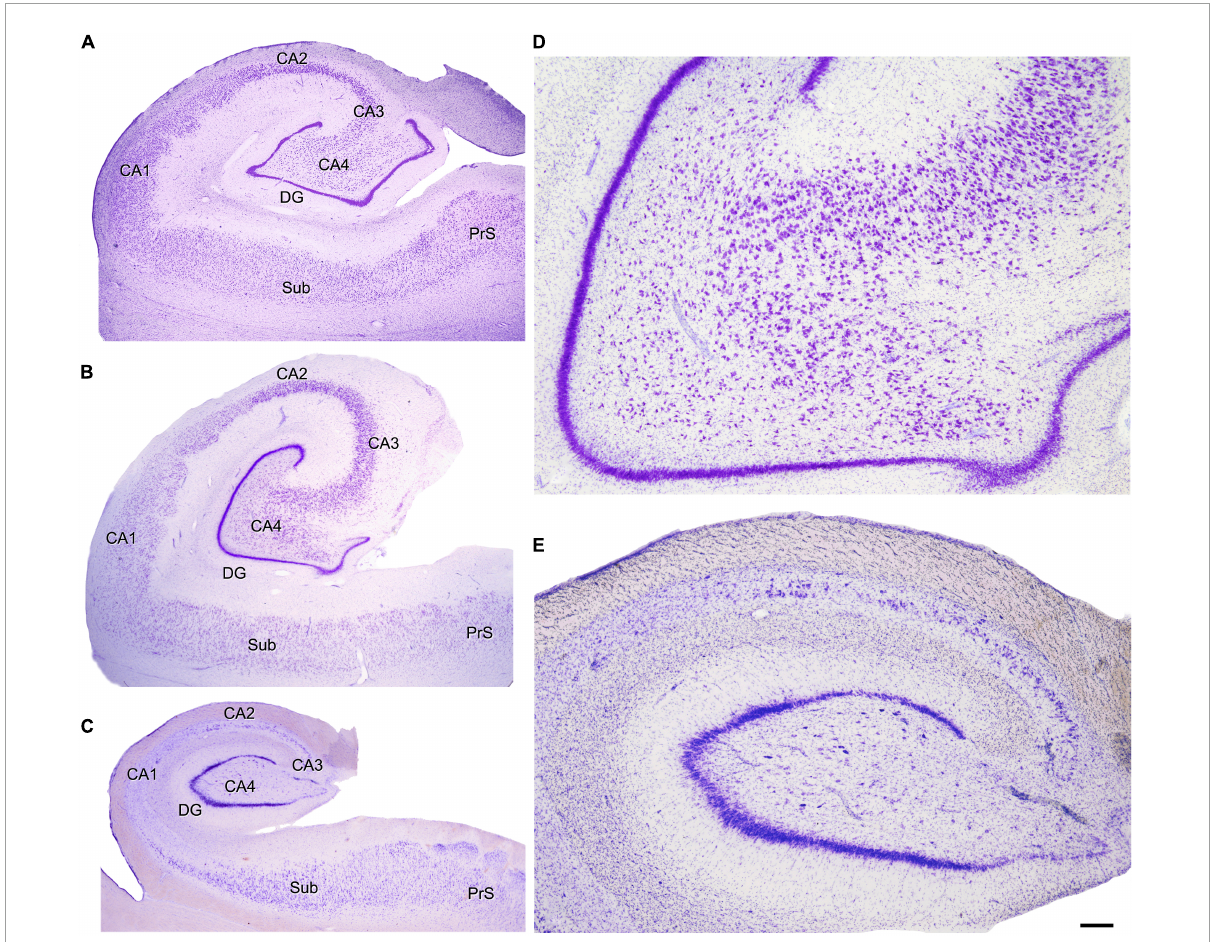
FIGURE4 Nissl-stained hippocampal sections. (A) Autopsy subject (female, 42 years old). (B) Epileptic patient without hippocampal sclerosis or any apparent hippocampal histopathology (H65; female 22, years old). (C) Epileptic patient with hippocampal sclerosis (H164; male, 23 years old). Note in panel (C) the hippocampal atrophy and loss of neurons in all hippocampal fields with relatively preserved DG and normal-looking subicular formation. See below section “Hippocampal sclerosis.” (D,E) Higher magnification of panels (B,C) , respectively, to illustrate the normal looking histological aspect of the NoHS-patients (D) and the loss of neurons in the HS-patients (E) . Because of the atrophy of the hippocampal formation, the DG and several CA hippocampal fields can be observed in panel (D) , whereas in panel (E) only the DG and CA4 are visualized, despite both pictures having been taken at the same magnification. CA1–CA4, cornu ammonis fields; DG, dentate gyrus; Sub, subiculum; PrS, presubiculum. Scale bar shown in panel (E) indicates 950 µ m in panels (A–C) and 240 µ m in panels (D,E) . Panels (A,B) have been taken